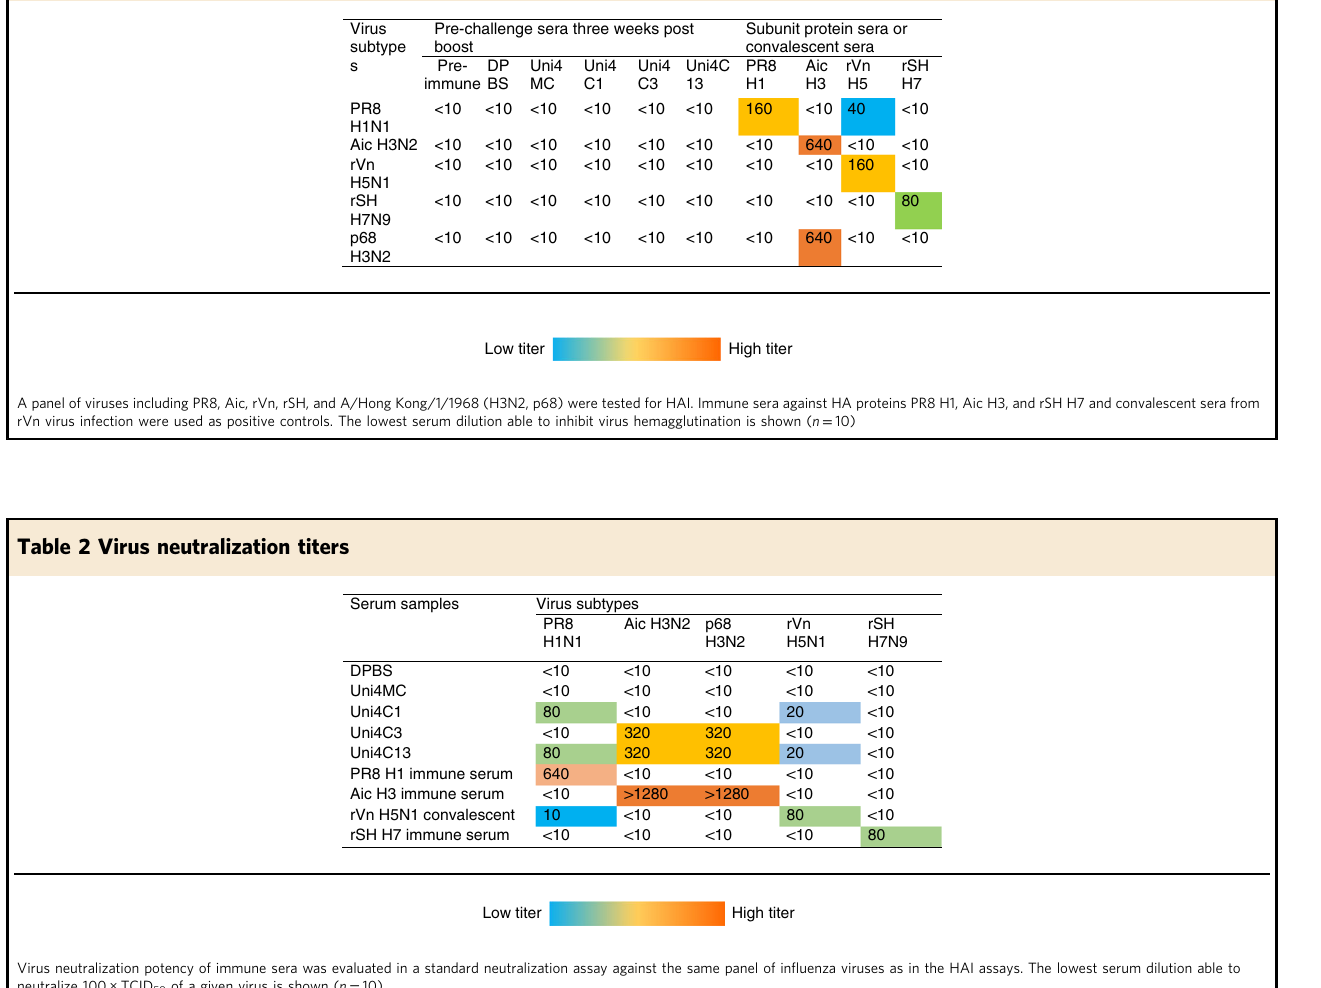
Pre-challenge sera three weeks post Virus boost subtype s